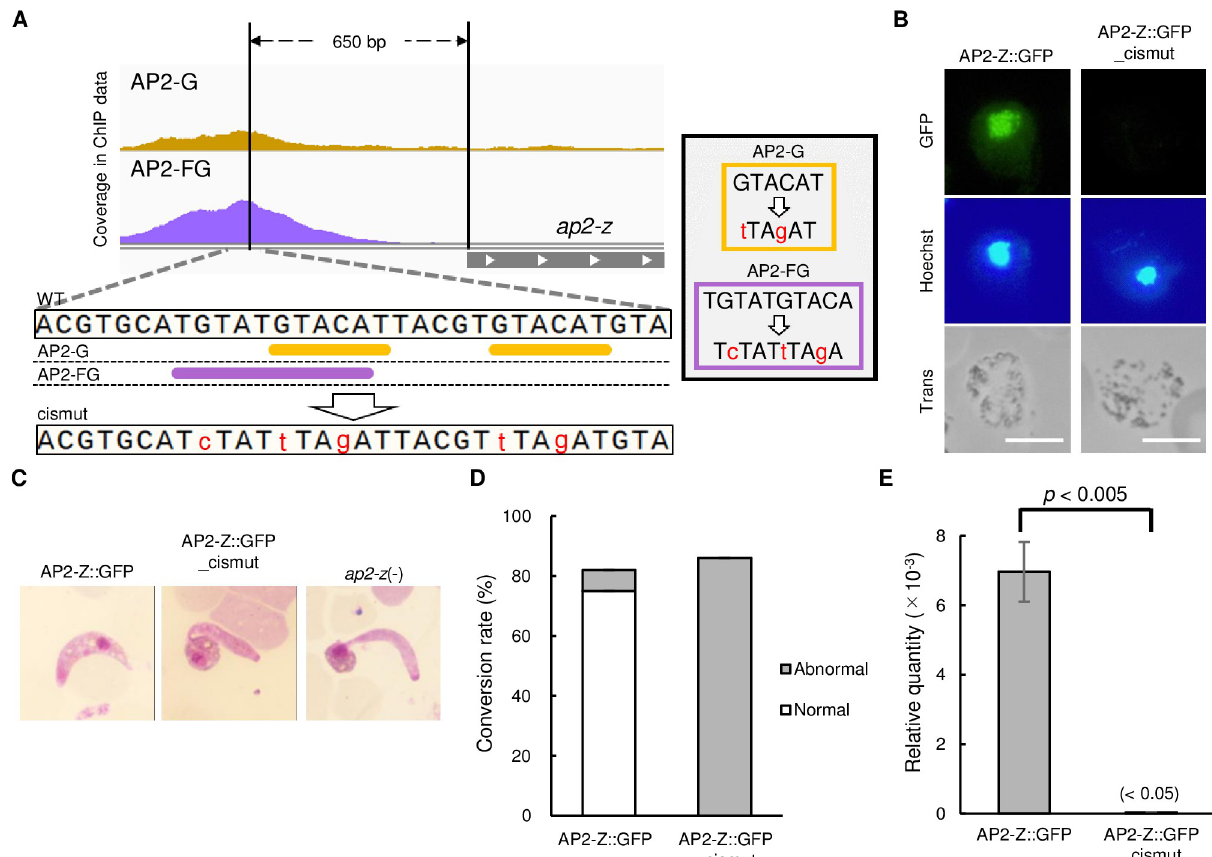
Fig 3. Transcriptional activation of ap2-z by AP2-G and AP2-FG. (A) Integrative Genomics Viewer images from the ChIP-seq data of AP2-G and AP2-FG for the upstream region of ap2-z . Binding motifs of AP2-G and AP2-FG in the peak region are indicated by orange and purple bars, respectively. Mutations introduced to these motifs are described on the right. The same mutations were introduced to both of the two AP2-G motifs. (B) Expression of AP2-Z in the AP2-Z::GFP_cismut at 6 hoc. Nuclei were stained with Hoechst 33342. Scale bar = 5 μ m. (C) Representative Giemsa-stained image of ookinete in AP2-Z::GFP, AP2-Z::GFP_cismut, and ap2-z (-) parasites at 20 hoc. (D) Rate of conversion to ookinetes against all female-derived cells in AP2-Z::GFP and AP2-Z::GFP_cismut at 20 hoc. (E) Relative amounts of ap2-z transcripts in gametocyte assessed by RT-qPCR analysis. The p28 gene was used as the internal control. Value for AP2-Z::GFP_cismut is given in brackets as it is too small to be depicted in the graph. The p -value on the graph was calculated by the Student’s t-test. Error bars indicate the standard error of the mean (n = 3).